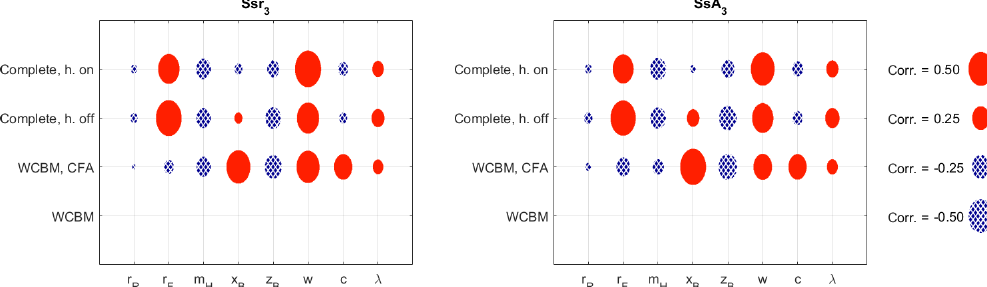
Figure 15. Correlation coefficients for the stability indices that consider the three modes (i.e., capsize, weave, and wobble). Models of increasing complexity from bottom to top. Speed range: 0 to 10ms − 1